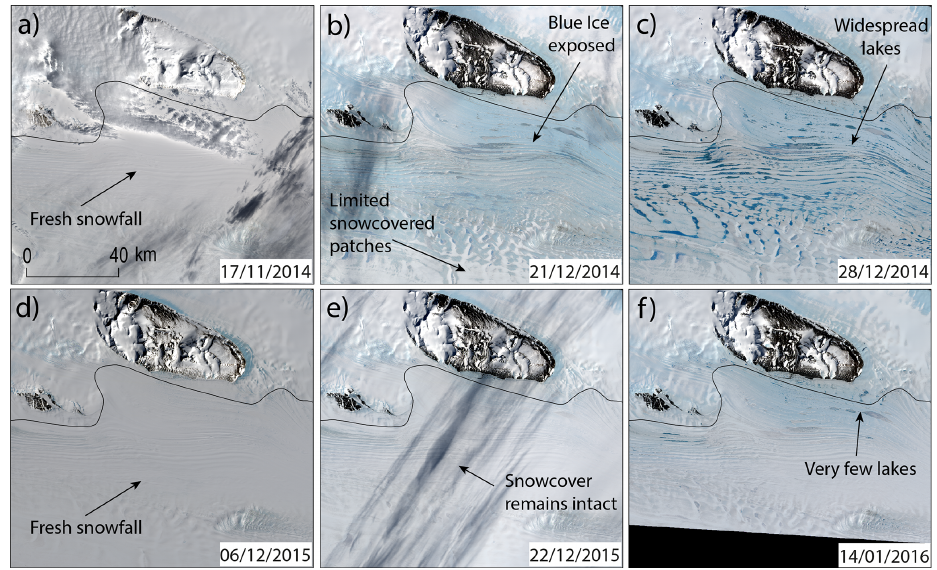
Figure 11. Landsat 8 images showing the evolution of the ice shelf surface to the east of the Fisher Massif in the 2014/15 (a–c) and 2015/16 (d–f) melt seasons. Landsat images are courtesy of the U.S. Geological Survey (https://earthexplorer.usgs.gov/, last access: 31 March